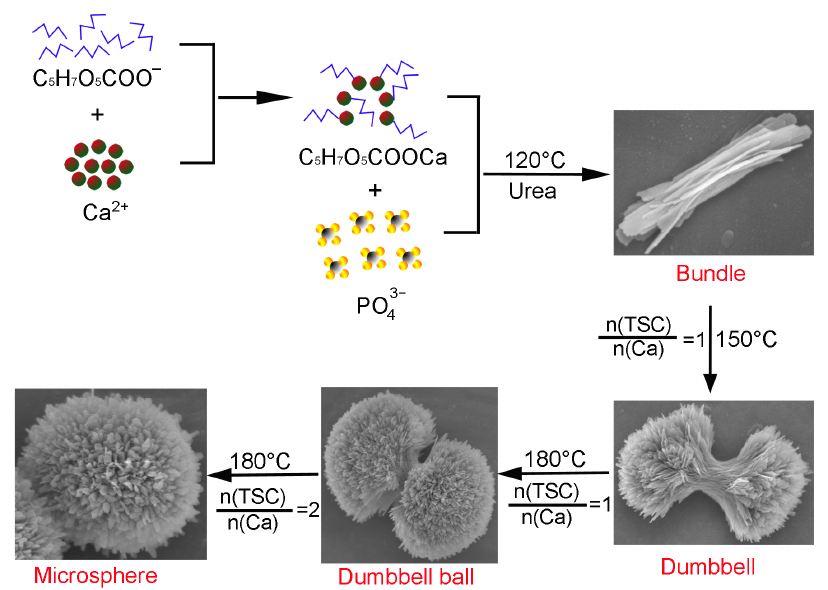
Figure 5. Formation mechanism of porous HA microspheres by TSC and urea via a hydrothermal route.